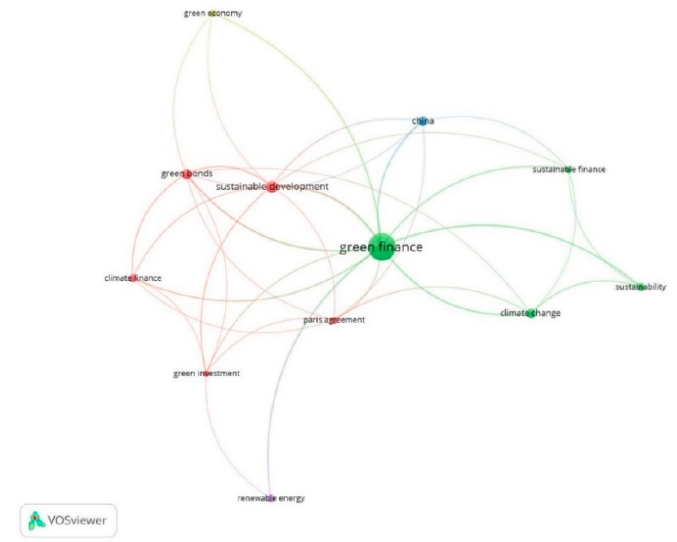
Figure 5. Co-occurrence of authors’ keywords (line 250).